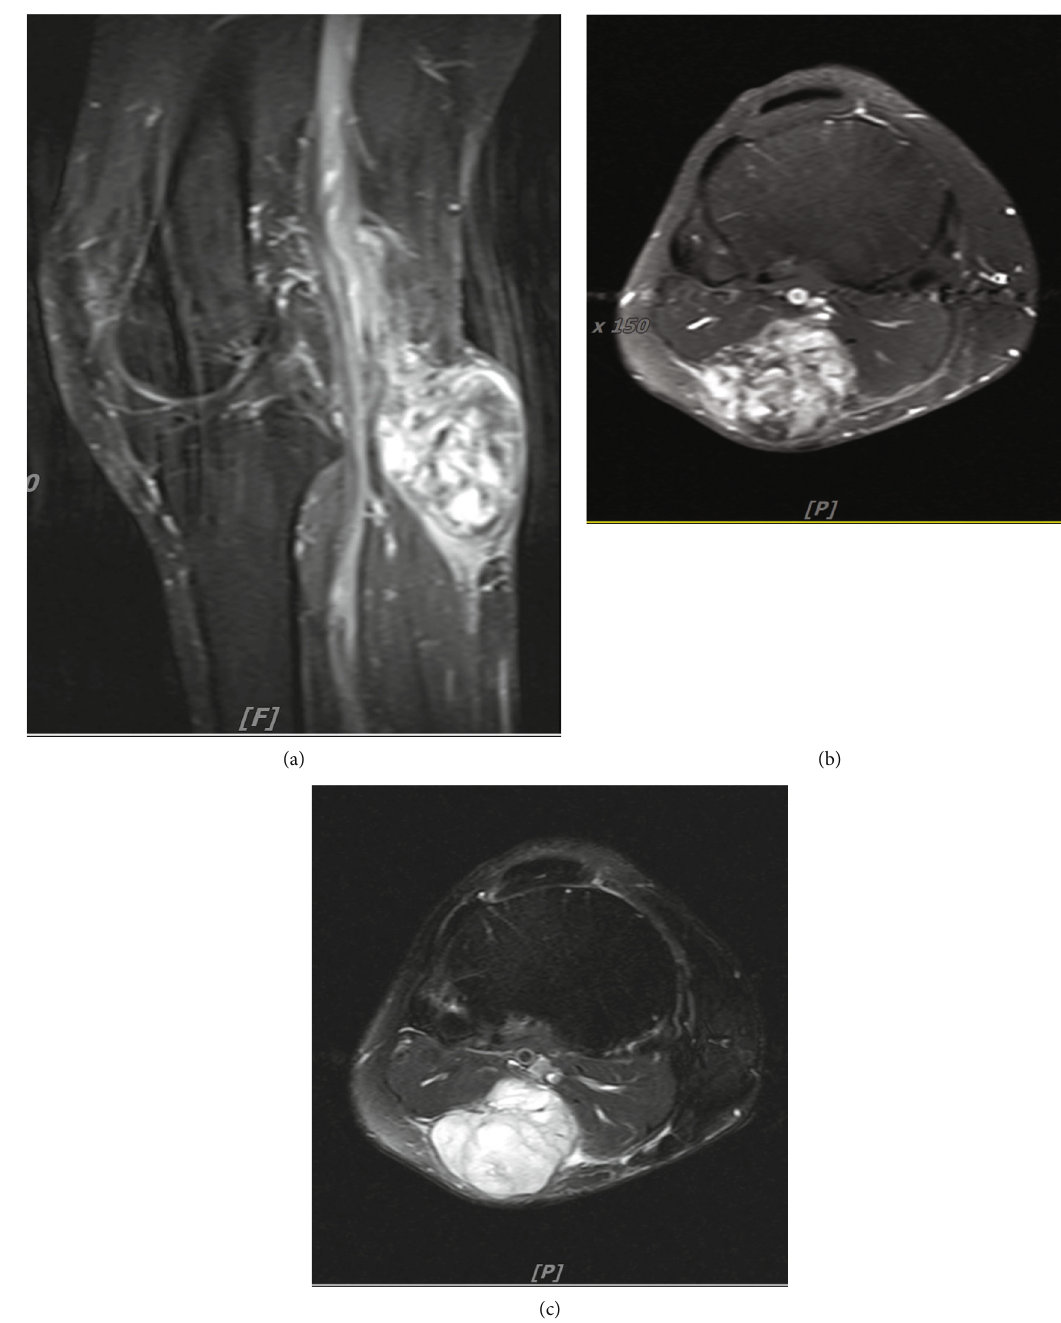
Figure 2: Magnetic resonance imaging. (a) Sagittal view with gadolinium contrast. (b) Axial view with gadolinium contrast. (c) Axial T2- weighted